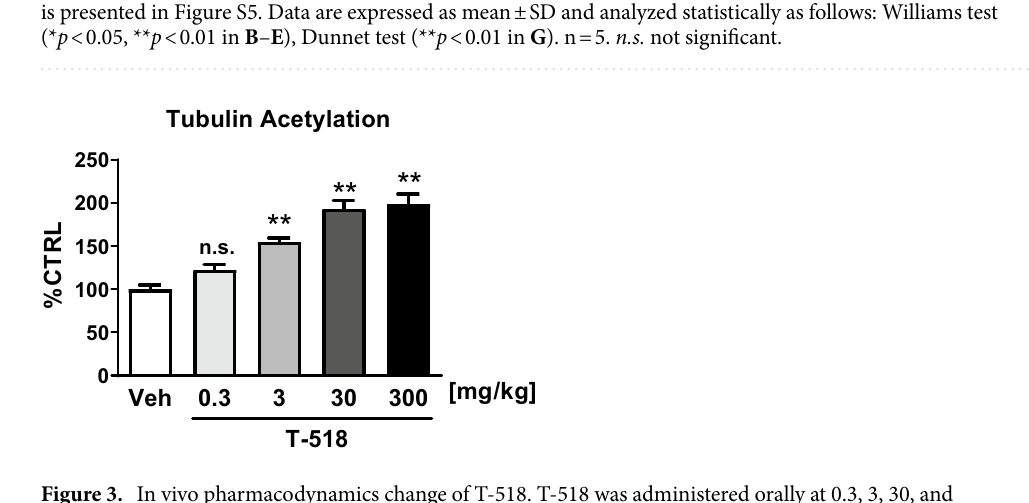
Figure 3. In vivo pharmacodynamics change of T-518. T-518 was administered orally at 0.3, 3, 30, and 300 mg/kg to 8-week-old male C57BL/6J mice. At 4 h after administration, the hippocampus was dissected and acetylated tubulin was evaluated by ELISA. Data are expressed as mean ± SEM and analyzed statistically as a follow: two-tailed Williams test (** p < 0.01), n = 6. n.s. not